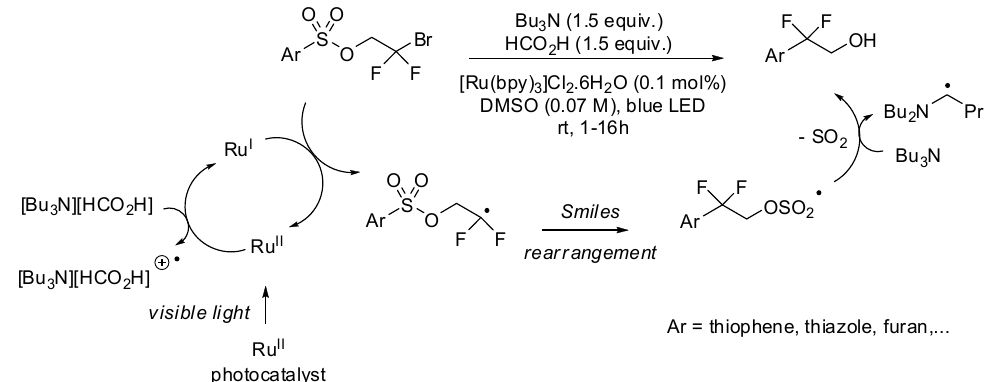
Scheme 1. Photocatalyzed radical Smiles rearrangement of difluorobromomethyl arylsulfonates.